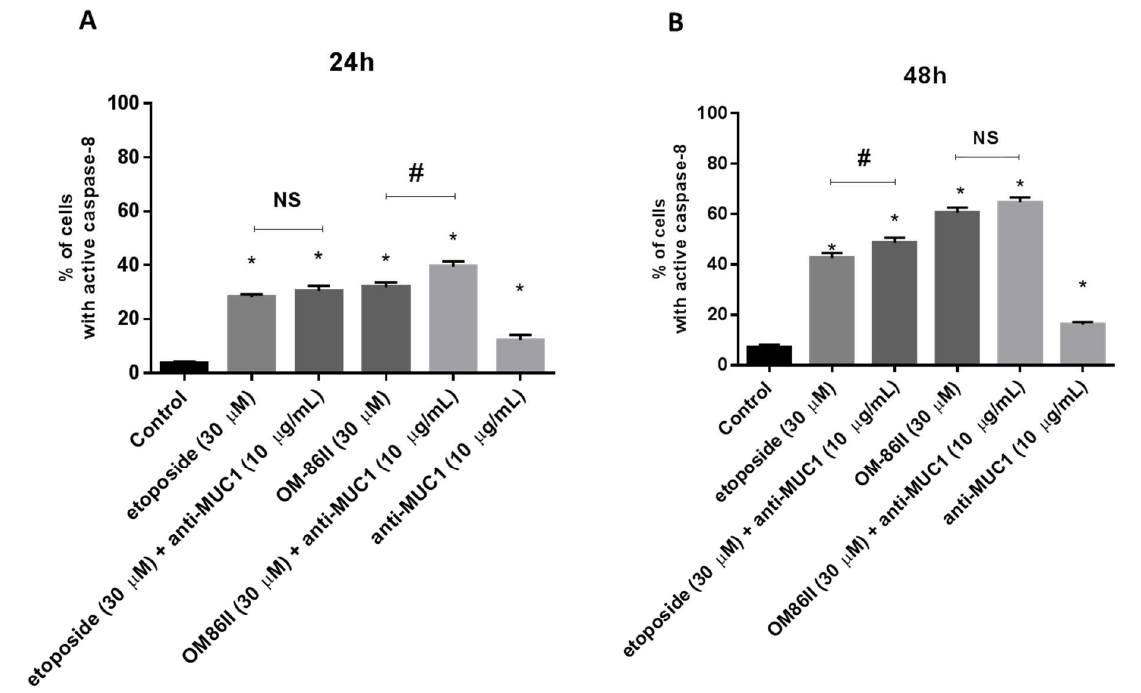
Figure 5. Caspase-8 activity in AGS gastric cancer cells treated for 24 h ( A ) and 48 h ( B ) with anti-MUC1 (10 µg/mL), OM-86II (30 µM), OM-86II + anti-MUC1 (30 µM + 10 µg/mL), etoposide (30 µM) and etoposide + anti-MUC1 (30 µM + 10 µg/mL) was demonstrated using flow cytometry. Mean percentage values from three independent experiments ( n = 3), performed in duplicate, are presented. * p < 0.05 vs. control group; # p < 0.05. MUC1, mucin-1; OM-86II, octahydropyrazin[2,1-a:5,4-a (cid:48) ]diisoquinoline derivative; NS, not significant.